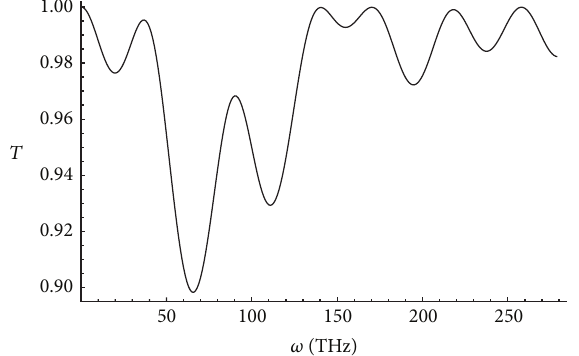
Figure 7: The layer’s transmittance 𝑇 versus frequency 𝜔 . Refractive index is discontinuous.